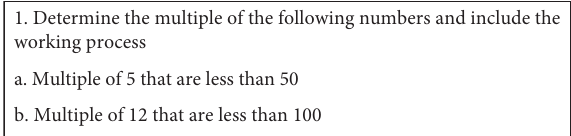
Figure 2: Questions of the multiple concept. Table 4: Distribution of students’ answer to question